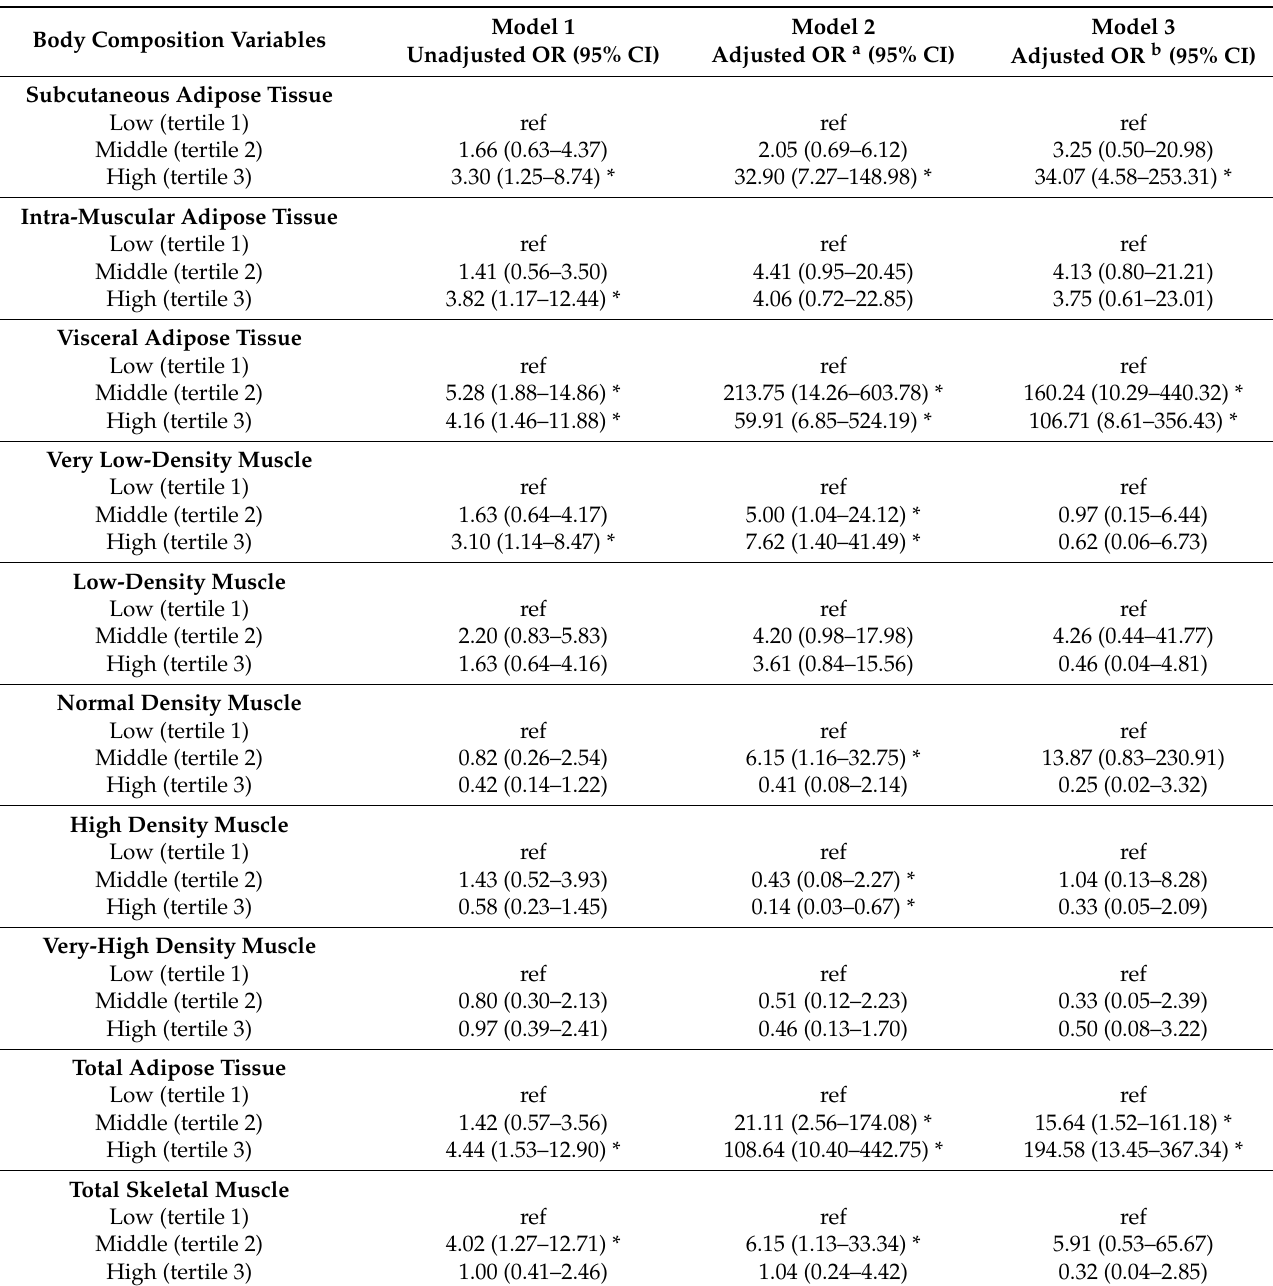
Table 3. Odds ratio (95% CI) for the association between specific body composition components and TNBC subtype among premenopausal women (<55